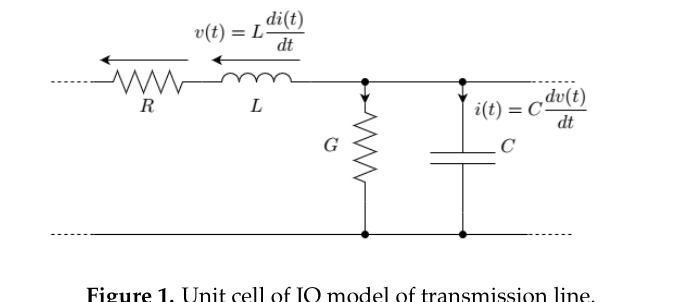
Figure 1. Unit cell of IO model of transmission